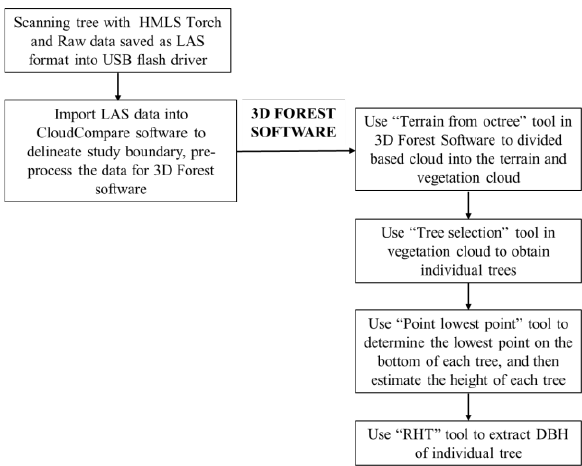
Figure 6 . The workflow of the